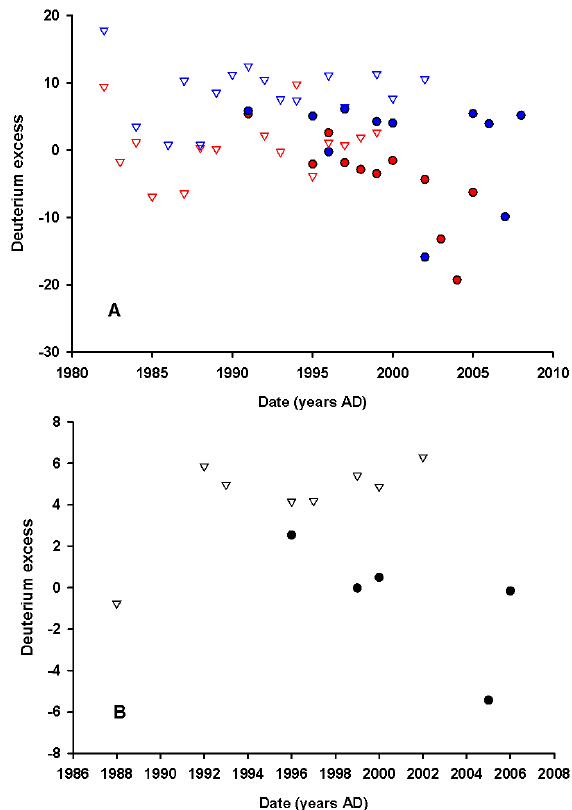
Fig. 6. Seasonal (A) and annual (B) amount-weighted averaged deuterium excess values for Punta Arenas (closed circles) and Ushuaia (open triangles). (A) seasonal d-values, blue=winter (JJA); red=summer (DJF). (B) annual d-values in black symbols. For Punta Arenas, DJF: r 2 =0.64, P < 0 . 005; JJA: r 2 = 0 . 08, P > 0 . 1. For Ushuaia, DJF: r 2 = 0 . 02, P > 0 . 1); JJA: r 2 = 0 . 01, P (cid:29) 0 .